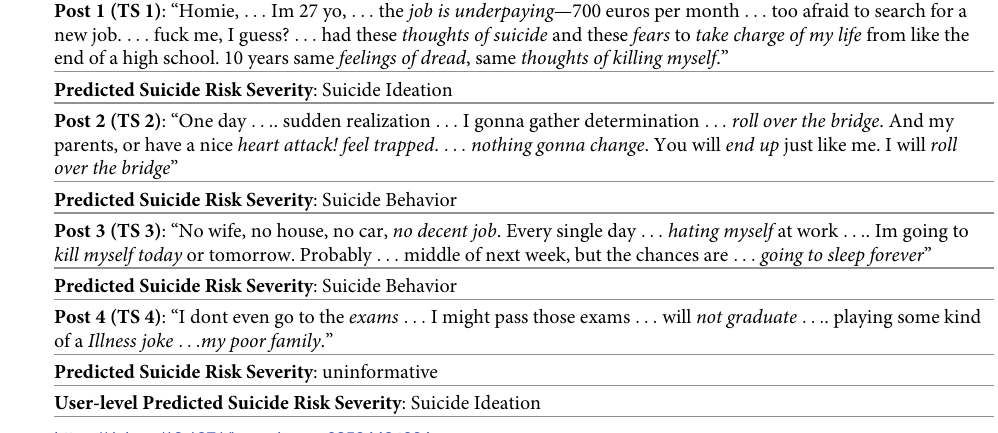
Table 4. Example posts from a user( u ) ordered by timestamp (TS) and prediction from TvarM. The italicized text i are phrases which contributed to the representation of each post. These phrases had similarity to the concepts in medi- cal knowledge